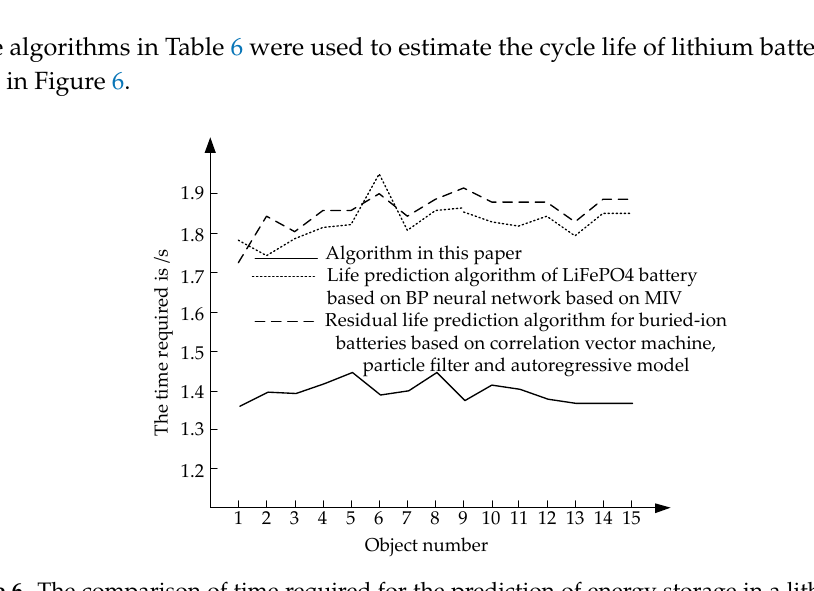
Figure 6. The comparison of time required for the prediction of energy storage in a lithium battery cycle life t when using three different algorithms.